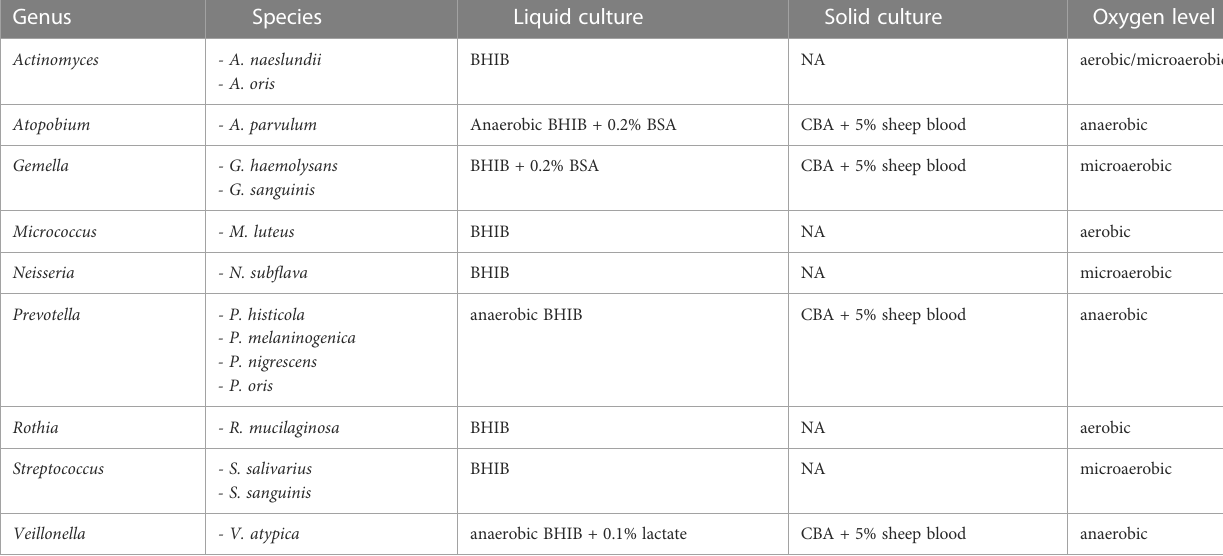
TABLE 1 Overview of species used in this study and their respective culture conditions.